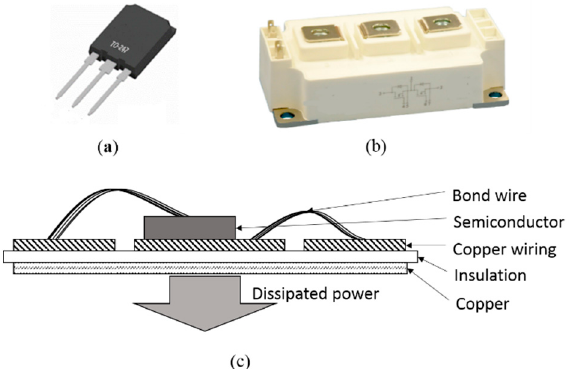
Figure 4. ( a ) Discrete device; ( b )Power module; ( c ) Power electronic device structure containing direct copper bonding (DCB) substrate.